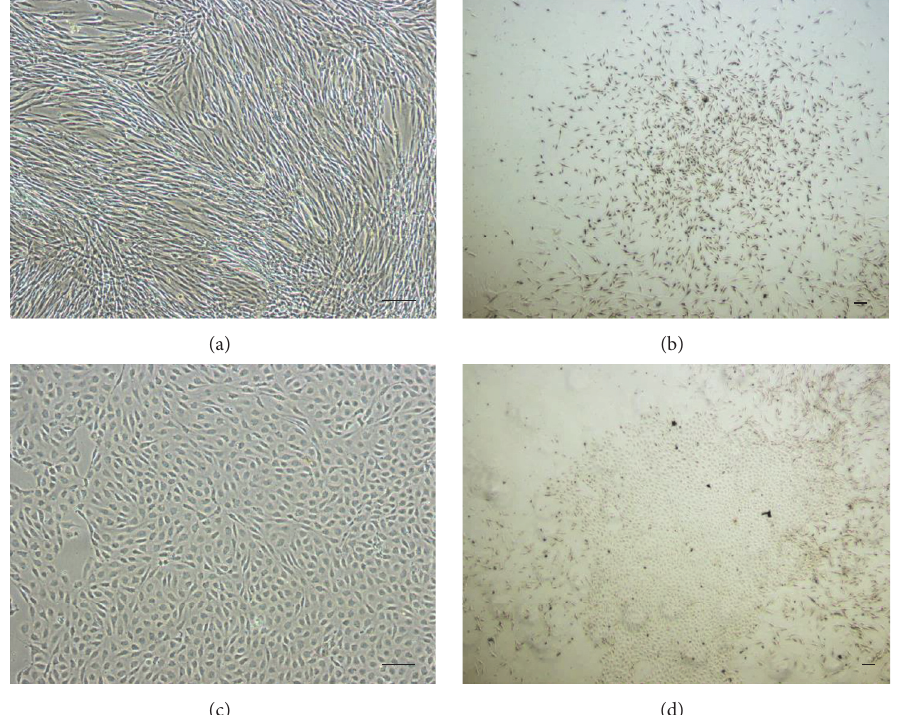
Figure 1: Different morphologies and clonogenic ability of LDSCs isolated from canine cranial cruciate ligament. (a)-(b) show sparse colonies with a fibroblastic cell morphology. (c)-(d) show dense colonies with a rounded, cobblestone cell morphology. Bars = 100 𝜇